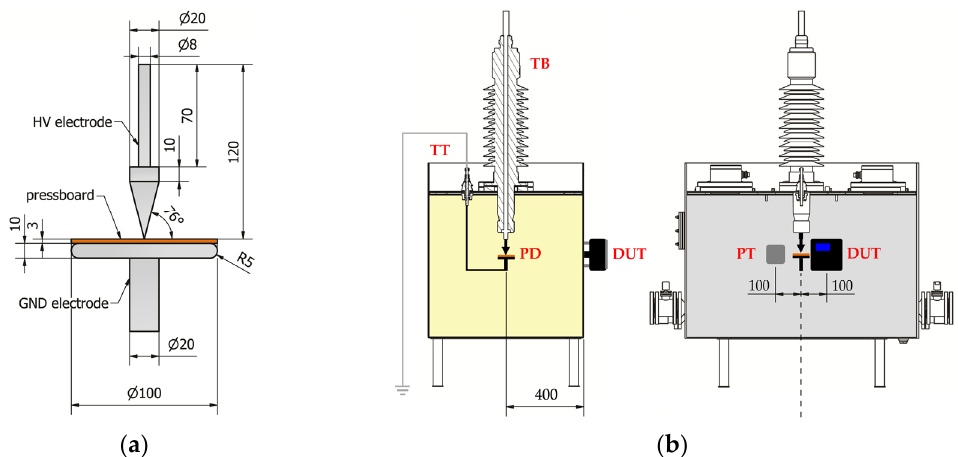
Figure 10. Test of the monitoring system in laboratory conditions: ( a ) electrode system for generating surface discharges; ( b ) arrangement of the tested and reference monitoring system on the transformer tank model: TT—oil filled transformer tank with electrode system for generating partial discharges; TB—transformer bushing; PD—electrode system for generating surface partial discharges PT—piezoelectric transducer A6890; DUT—system under test.